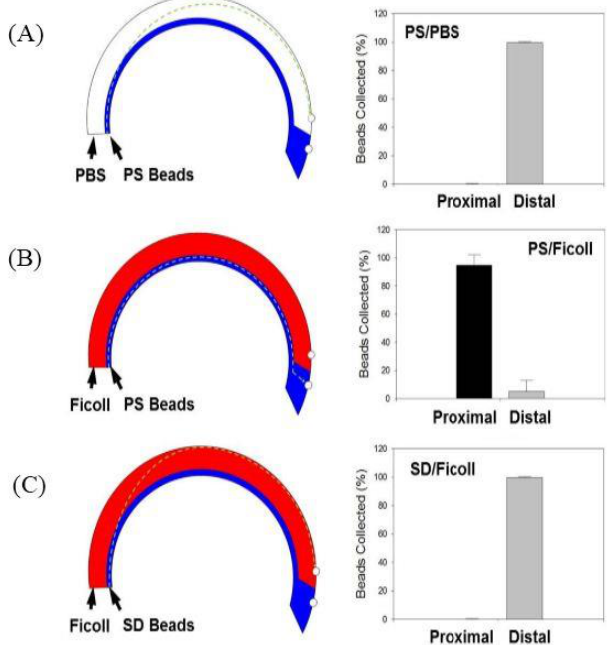
Figure 3. Proof-of-Concept Studies were established by flowing either polystyrene (PS) or silicon dioxide (SD) beads solutions with either 1X PBS or Ficoll to determine migration behavior and isolation via either the proximal or distal outlets. On the left is the schematic with hypothesized path of travel through the microfluidic channel at a speed of 875 rpm (40 g), and on the right is a plot with % of beads collected at each outlet for the following conditions: ( A ) PS Beads and 1X PBS; ( B ) PS Beads and Ficoll and ( C ) SD Beads and Ficoll ( n = 5).